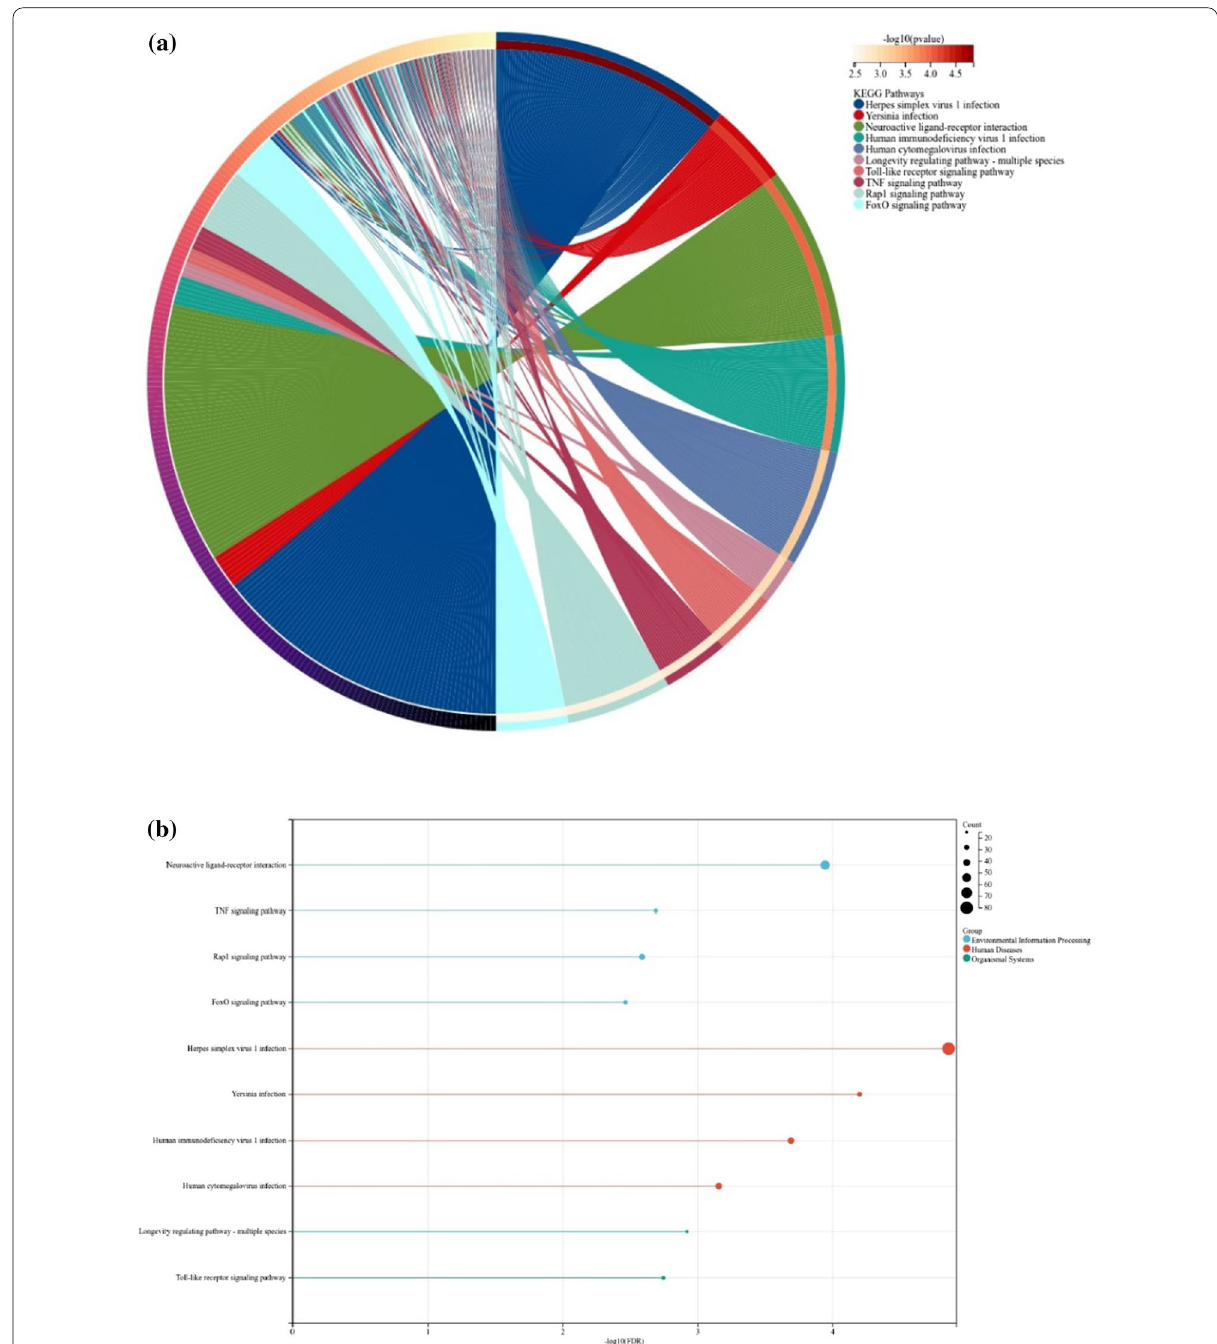
Fig. 4 a Fig. 4a shows the chord diagram of the results of the KEGG pathway enrichment in the non-daily alcohol user group. In this figure, the following signaling pathways were enriched, HSV-1 infection, Yersinia infection, neuroactive ligand-receptor interaction , human immunodeficiency virus-1 infection, and human cytomegalovirus infection. b Fig. 4b shows the histogram of the results of the KEGG pathway enrichment in the non-daily alcohol user